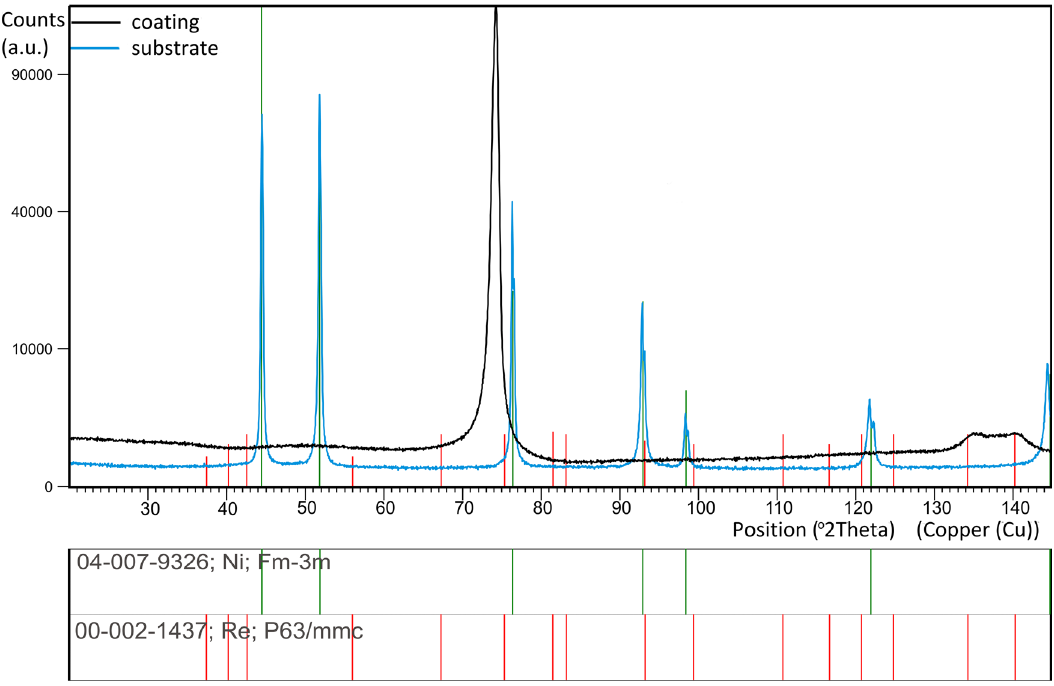
Figure 4: X - ray di ff raction pattern of the Ni – 37Re coating ( j = 25 mA · cm − 2 , 5 g · L − 1 of ammonium rhenate ( VII ) in the bath ) and substrate.